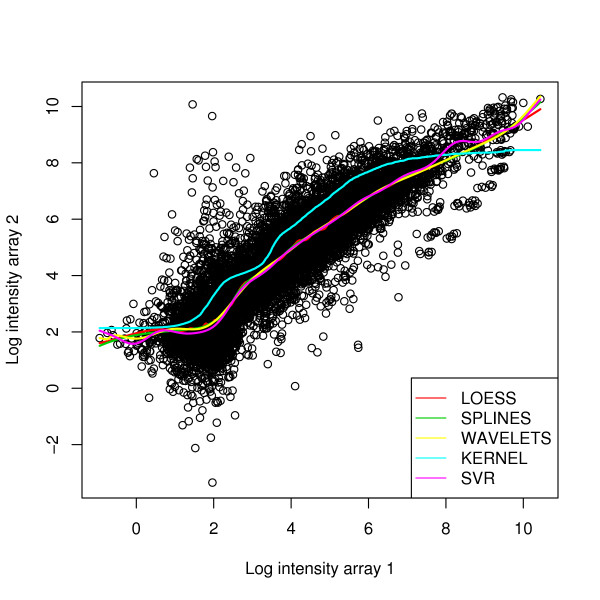
Fitted normalization curves for actual cDNA microarray data using the five different normalization methods (Loess, Splines, Wavelets, Kernel, SVR).